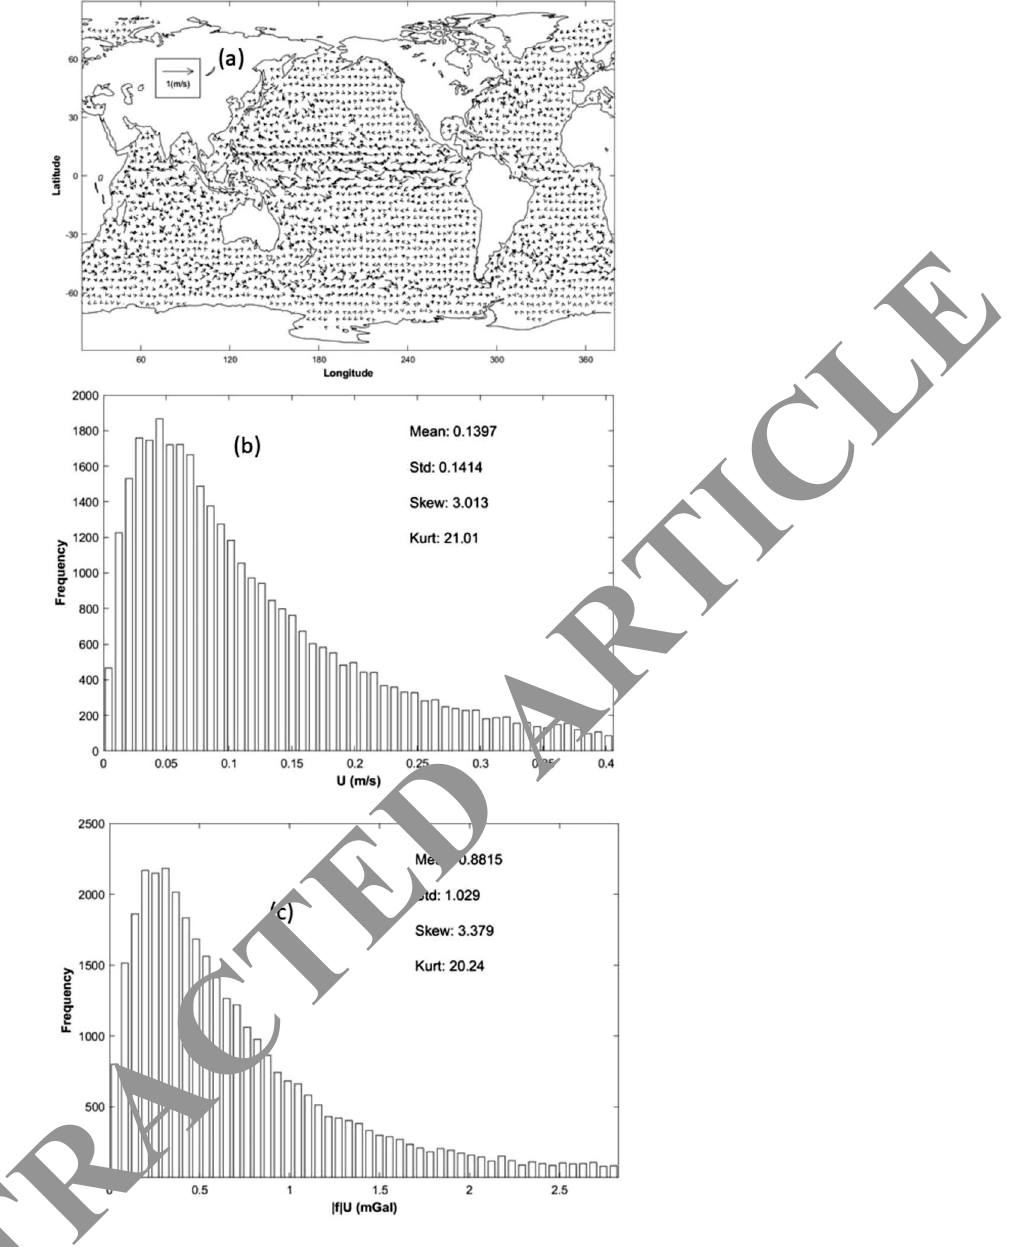
Figure 3. ( a ) The world ocean surface current vectors on 26 February 2020 from the ocean surface current analysis real-time (OSCAR) dataset which was downloaded from the website https:// podaac- tools. jpl. nasa. gov/ drive/ files/ allDa ta/ oscar/, ( b ) histogram of the current speed U , and ( c ) histogram of the intensity of the Coriolis f U . The source codes for the plots were written by the author’s research group using the Matlab Version force R2019b (https:// www. mathw orks. com/ produ cts/ matlab. (cid:31) (cid:31) (cid:31) (cid:31) speed U ( x , y ) (Fig. 3b) indicates a positively skewed distribution with a long tail extending to values larger than 0.4 m/s. The statistical characteristics of U are 0.1397 m/s as the mean, 0.1414 m/s as the standard deviation, 3.013 as the skewness, and 21.01 as the kurtosis. The histogram of the corresponding Coriolis force | f | U ( x , y ) (Fig. 3c) also shows a positively skewed distribution with a long tail extending to values larger than 2.5 mGal. The statistical characteristics of | f | U are 0.8815 mGal as the mean, 1.029 mGal as the standard deviation, 3.379 as the skewness, and 20.24 as the kurtosis. Comparison between Figs. 2d and 3c leads to the fact that the mean intensity of horizontal gravity component | g h | (= 20.84 mGal) is nearly 24 times as large as the mean intensity of the Coriolis force identified from the OSCAR surface currents on 26 February 2020. Such unexpectedly large horizontal gravity component is also shown in the world ocean distribution of (1/ C 0 ) values (Fig. 4a). The histo- gram of (1/ C 0 ) (Fig. 4b) indicates a positively skewed distribution with a long tail extending to values larger than 0.18. The statistical characteristics of (1/ C 0 ) are 0.04238 as the mean, 0.04108 as the standard deviation, 1.447